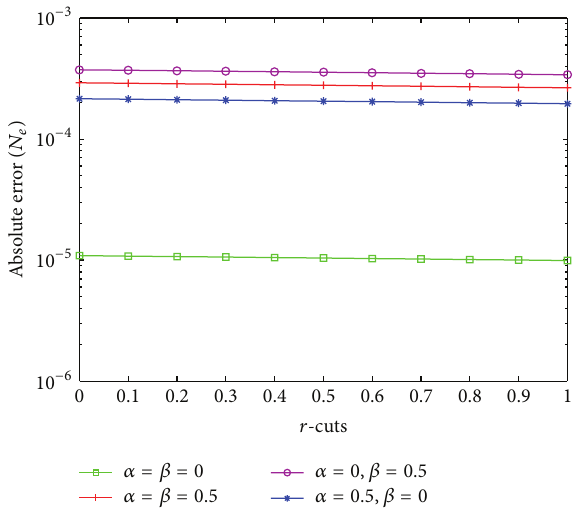
Figure 5: The absolute errors for different 𝛼 and 𝛽 with 𝑁 = = 0.1386 , and V = 0.95 , Case II. 8 , 𝑘 2